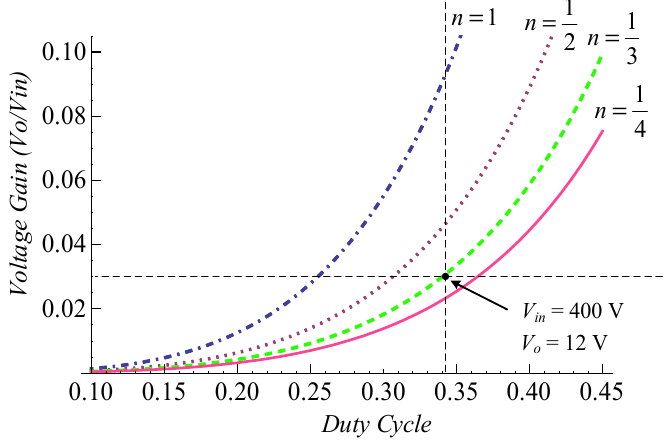
Figure 11. Relationship among voltage gain, duty ratio, and turns ratio.